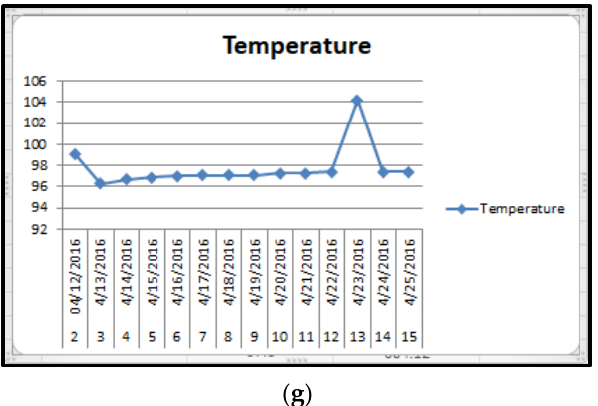
Figure 4. ( a ) Federated Learning Architecture. ( b ) Dataset including daily steps and calories. ( c ) Graphical representation of calories based on daily steps. ( d ) Average Heart Rate Dataset. ( e ) Graphical representation of heart rate. ( f ) Dataset of Body Temperature Per Day ( g ) Graphical representation of body temperature.